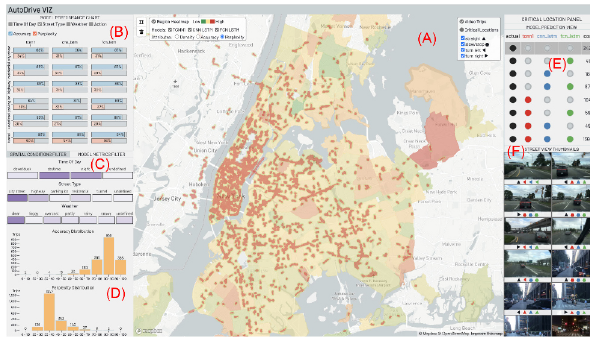
Fig. 10 Interface of a geographical-context based diagnosis system for autonomous driving models. Reproduced with permission from Ref. [77], c (cid:13) IEEE 2022.